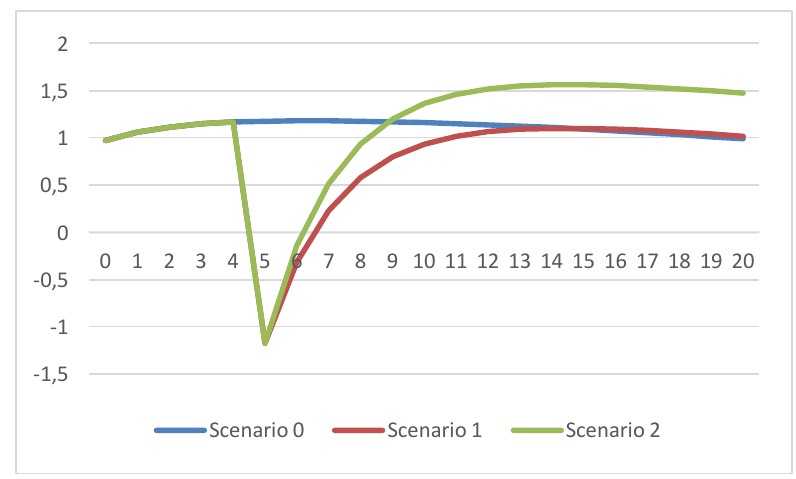
Fig. 7 . GDP growth rates